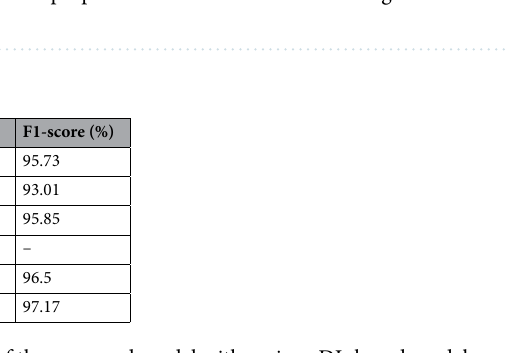
Table 5. Performance comparison of the proposed model with various DL-based models on the WISDM dataset.